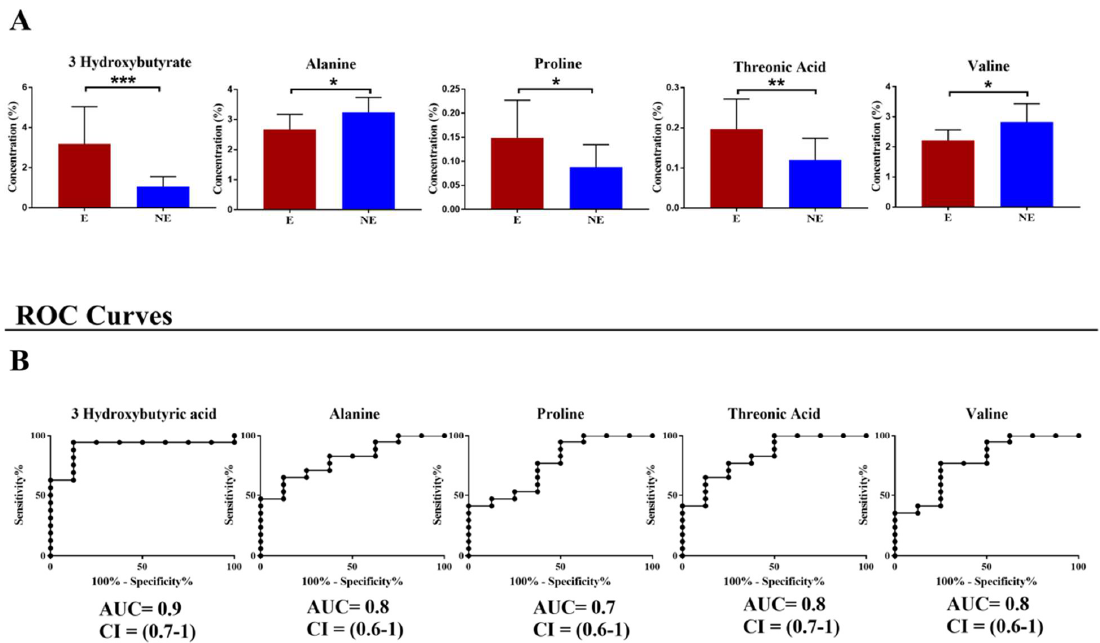
Figure 2. Univariate comparisons between Endometriosis (E) and Not−Endometriosis (NE) samples. ( A ) Graphs of the most important metabolites which changed their concentration with a * p −value < 0.05; ** p −value <0.01; *** p −value < 0.001. The red bar indicates E patients while the blue bar indicates NE patients; ( B ) ROC curves of the discriminant metabolites.